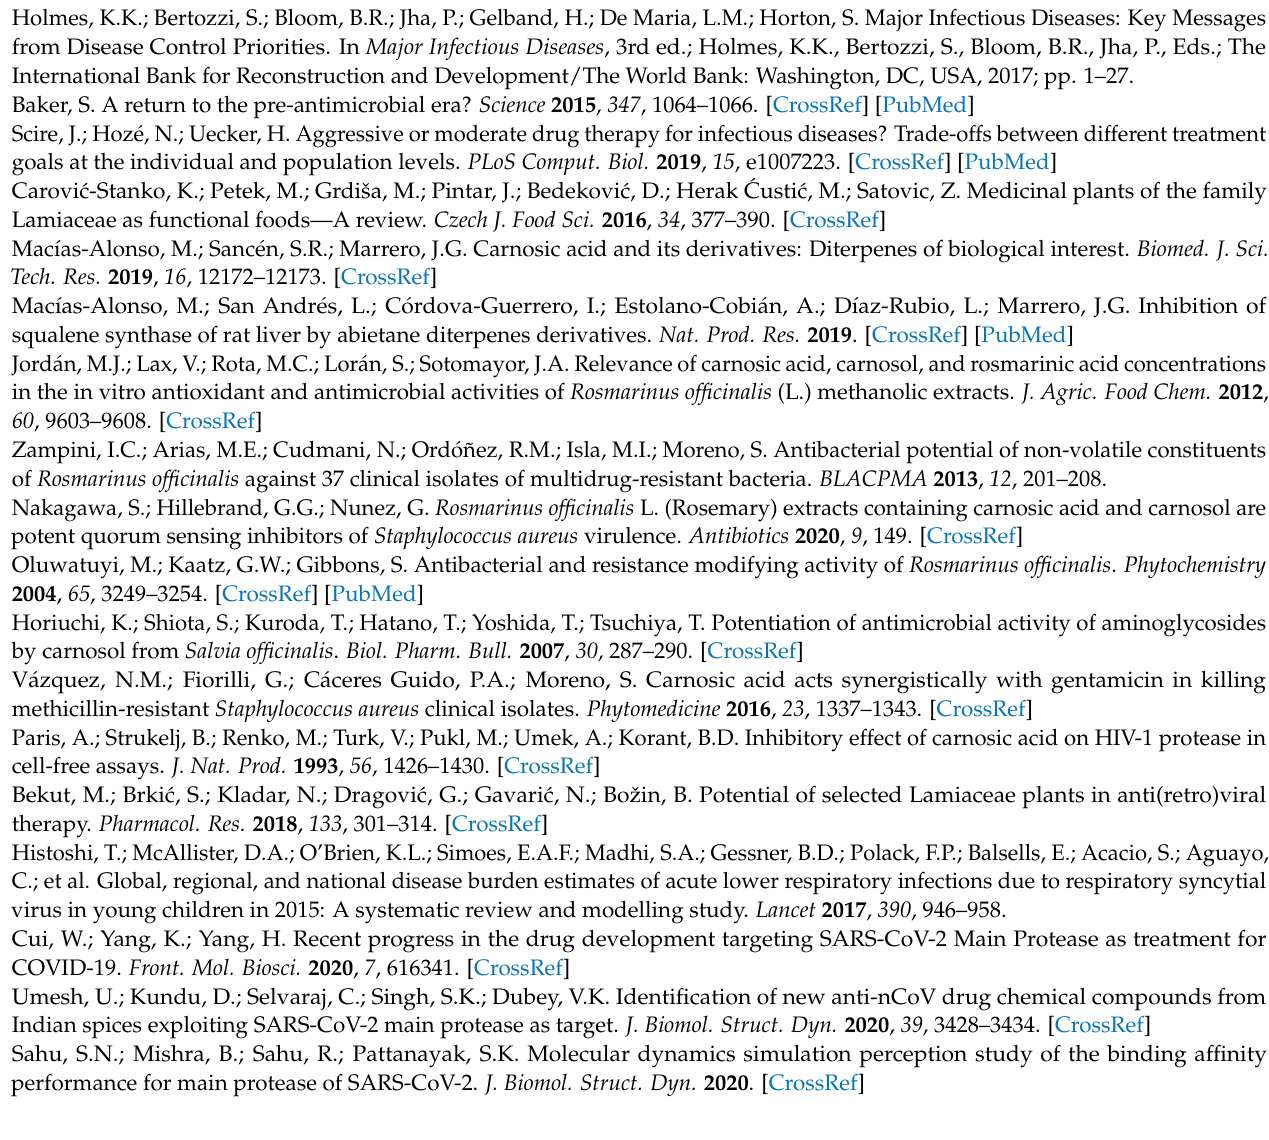
chromatography of acetonic extracts of callus samples from fractions 1–12, Table S4: Validation parameters for the determination of carnosol by HPLC-DAD, Table S5: Influence of the flow of the mobile on retention time (tR), dead time (t0) and retention factors (k’), Figure S6: Calibration curve for carnosol, Figure S7: Chromatogram of carnosol at 370 µ g mL − 1 , Figure S8: Chromatogram of the Figure S9: Characteristic HPLC profile of the acetonic extract of a callus sample of R. officinalis